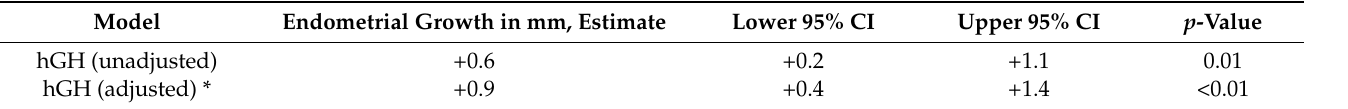
Table 3. Unadjusted and adjusted linear mixed models-endometrial growth in human growth hormone (hGH) cycles is reported (as compared to non-hGH